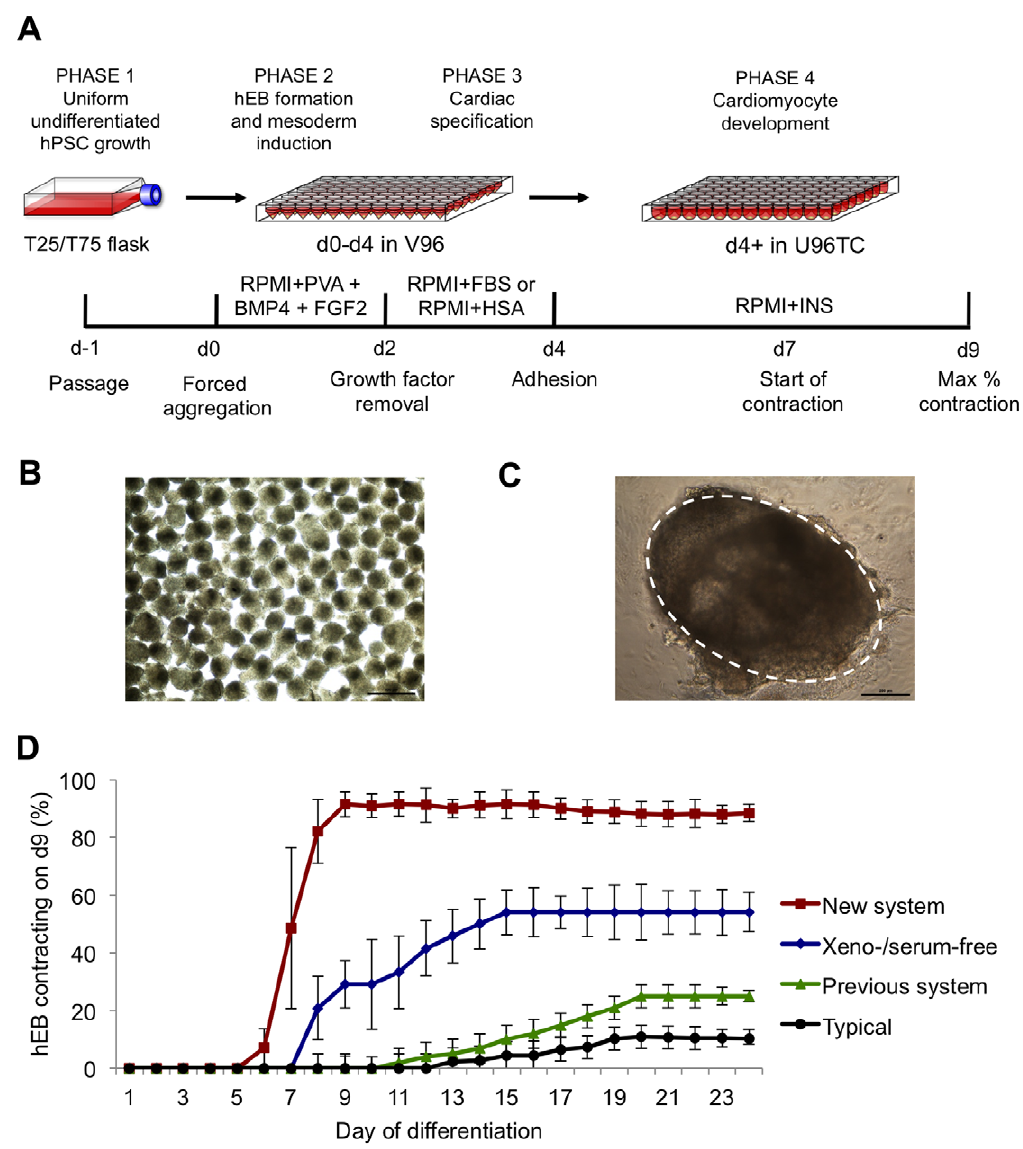
Figure 1. Systematic optimization of cardiac differentiation of human pluripotent stem cells. ( A ) Schematic of the optimized cardiac differentiation system demonstrating: Phase 1, uniform growth of hESC/hiPSC as monolayers. Phase 2 (d0–d2), aggregation of 5000 single cell hESC or hiPSC in chemically defined RPMI + PVA medium in V96 plates. Phase 3 (d2–d4), cardiac specification using FBS or hSA containing medium. Phase 4 (d4 + ), cardiac development, hEB are allowed to adhere to U96 tissue culture treated plates in RPMI + INS. ( B ) Typical d2 hEB formed using the forced aggregation procedure in RPMI-PVA to demonstrate homogeneity in hEB size. Scale bar=500 m m. ( C ) Typical d9 contracting hEB formed using the optimized cardiac differentiation method with the contracting area circled, note minimal fibroblast outgrowth. Scale bar=200 m m. ( D ) Efficiency of generation of contracting hEB produced in this system (New system, n =48), with comparisons to xeno- and serum-free conditions (Xeno-/serum-free, n =5), our previous method (Previous system, n =7), and typically used methods (Typical, n =9). Error bars, 6 S.E.M.